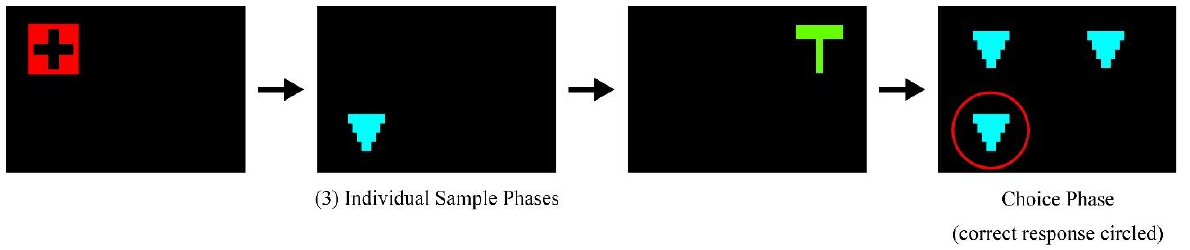
Example Trial for the Paired Associates Learning (PAL) Task